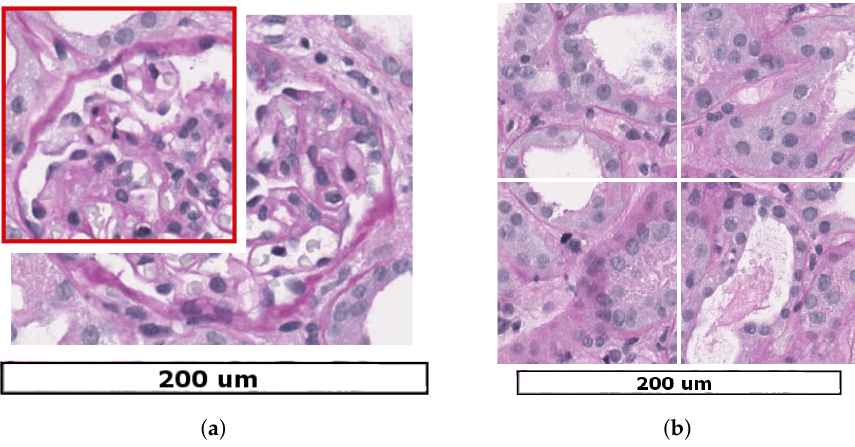
Figure 3. Graphical representation of blocks generation for Glomerulus and non-Glomerulus classes with 227 × 227 pixels size. ( a ) Representation of Glomerulus block extraction; ( b ) Representation of non-Glomerulus